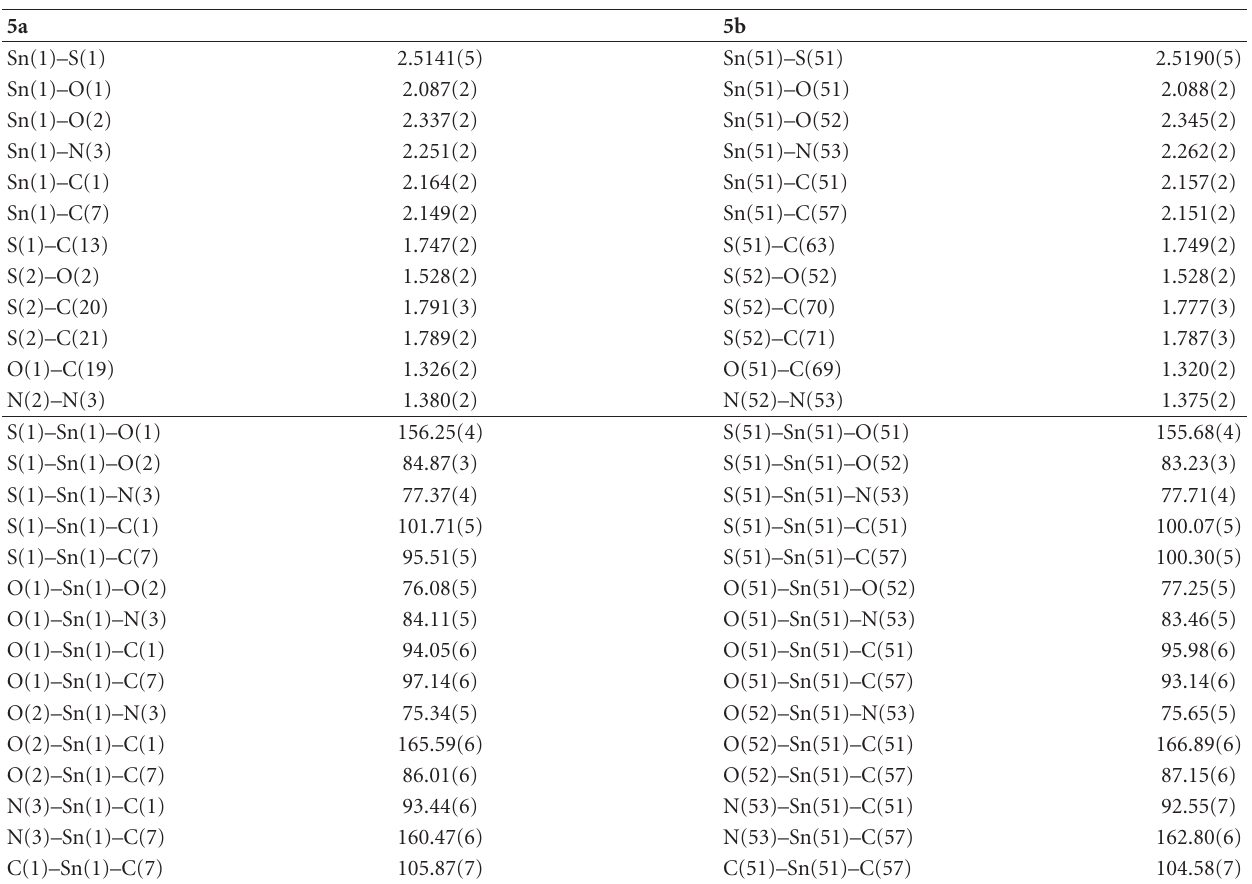
Table 2: Bond lengths ( ˚A) and angles ( ◦ ) for complex